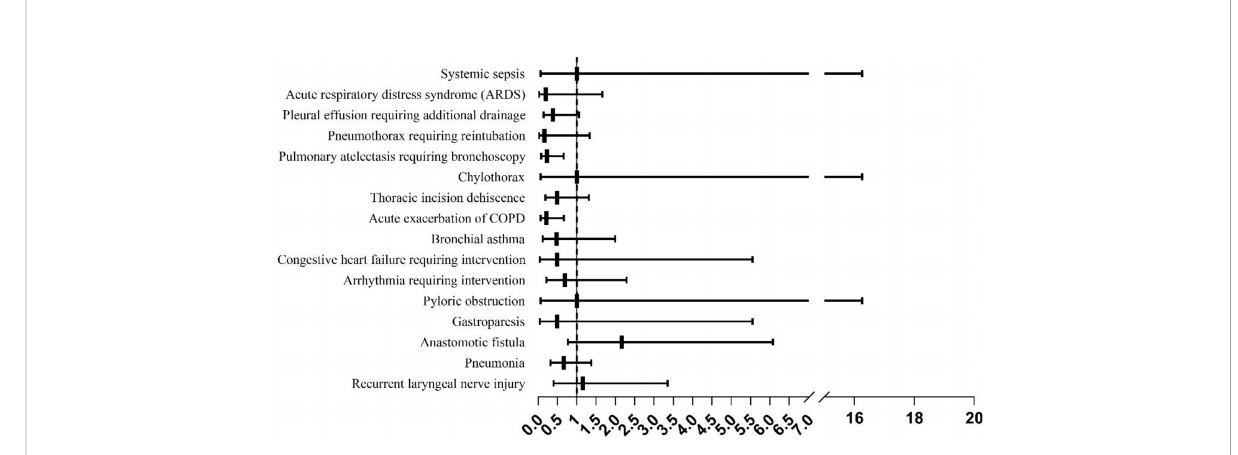
FIGURE 2 The incidence of complications in the minimally invasive esophagectomy (MIE) and open esophagectomy (OE)